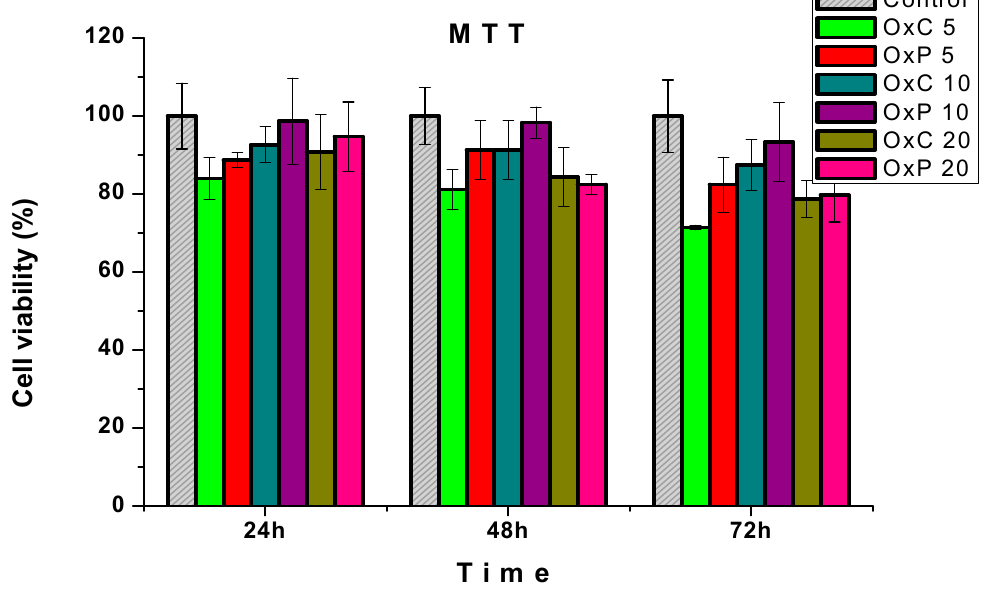
Figure 9. The most significant results of the cytotoxicity evaluation, performed on the PVA / carboxylated polysaccharide hydrogels by using the MTT assay.